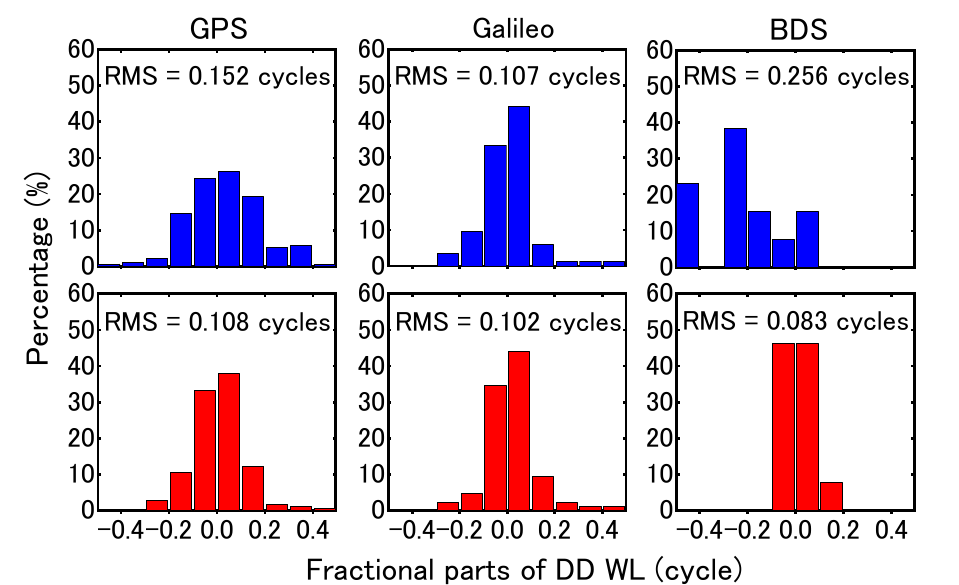
Figure 7. Histogram distribution of the fractional parts of double difference (DD) wide-lane (WL) ambiguities for baseline MAR6_MAR7 on DOY 101, 2019, without ( top row ) and with ( bottom row ) receiver-related pseudorange biases correction.